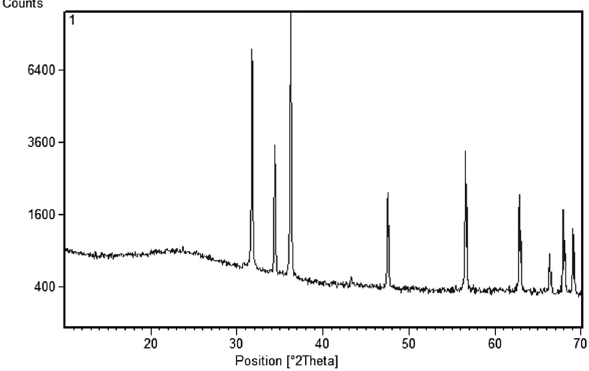
Figure 2: XRD pattern of SiO 2 ( AG ) /T - ZnO